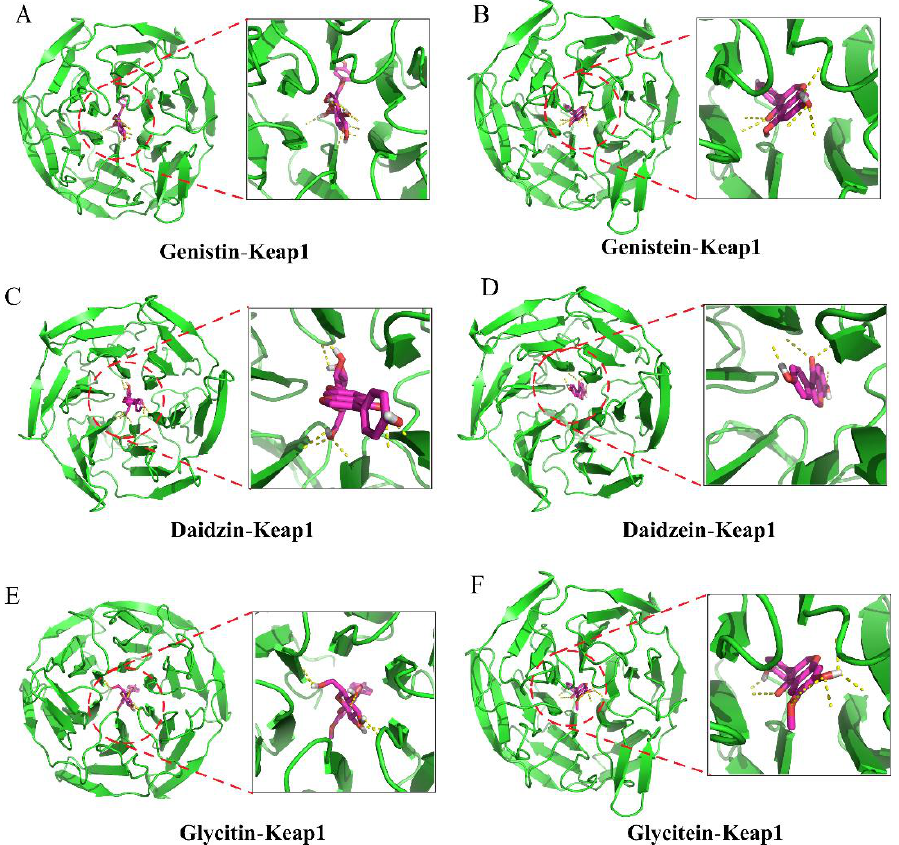
Figure 5. Molecular docking analysis of the interactions between isoflavones and Keap1 protein (3D diagram). ( A ) Genistin bound to keap1. ( B ) Genistein bound to keap1. ( C ) Daidzin bound to keap1. ( D ) Daidzein bound to keap1. ( E ) Glycitin bound to keap1. ( F ) Glycitein bound to